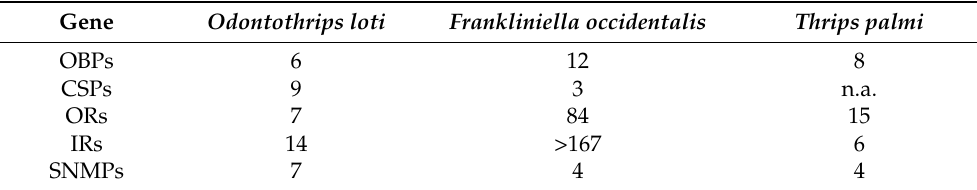
Table 4. Quantitative statistics of olfactory candidate genes found in O. loti compared to F. occidentalis and T. palmi . Gene Odontothrips